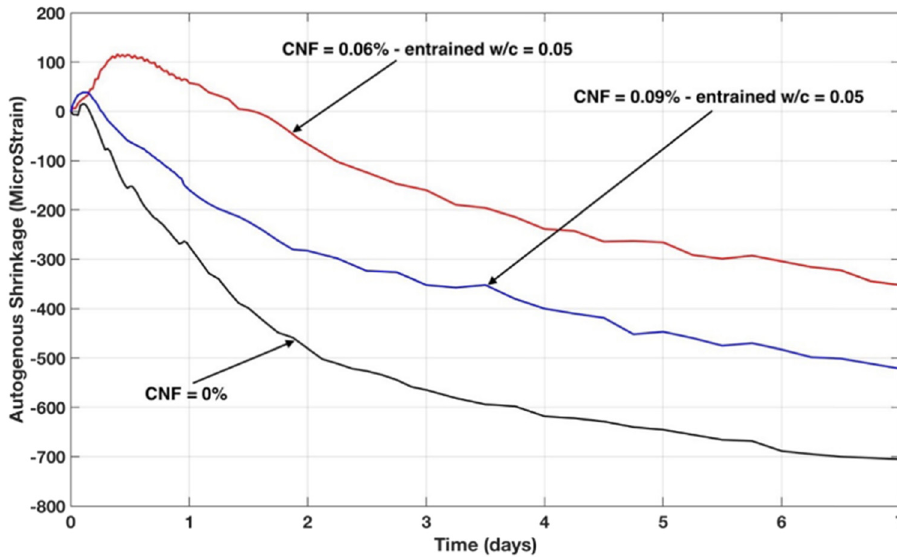
Figure 29: Autogenous shrinkage of cellulose nano fi brils - reinforced cement pastes as a function of time, reprinted with permission from ref. [ 37 ] ; Copyright 2019, The University of Maine.